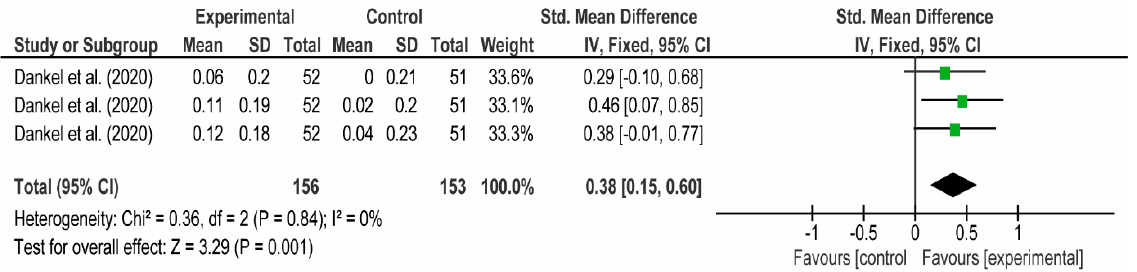
Figure 23. The effect size of isometric maximal voluntary co-contraction training on the elbow flex- ors MT. References for the studies in the table with the same publication year are Maeo et al. (2014) [83], Maeo et al. (2014a) [84].